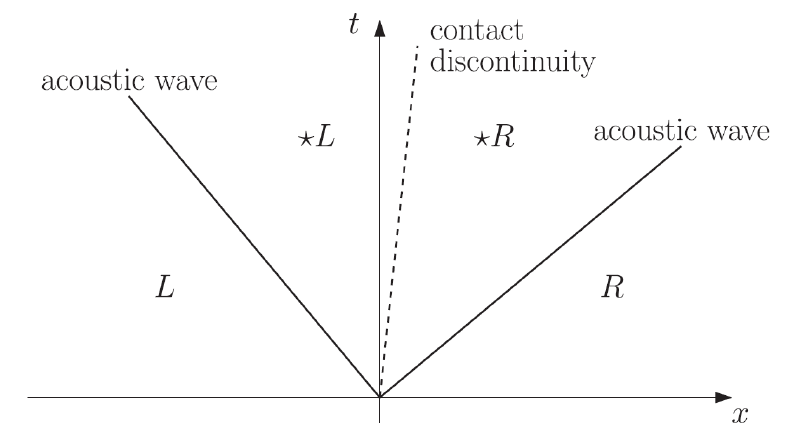
Figure 1. Structure of the Riemann problem